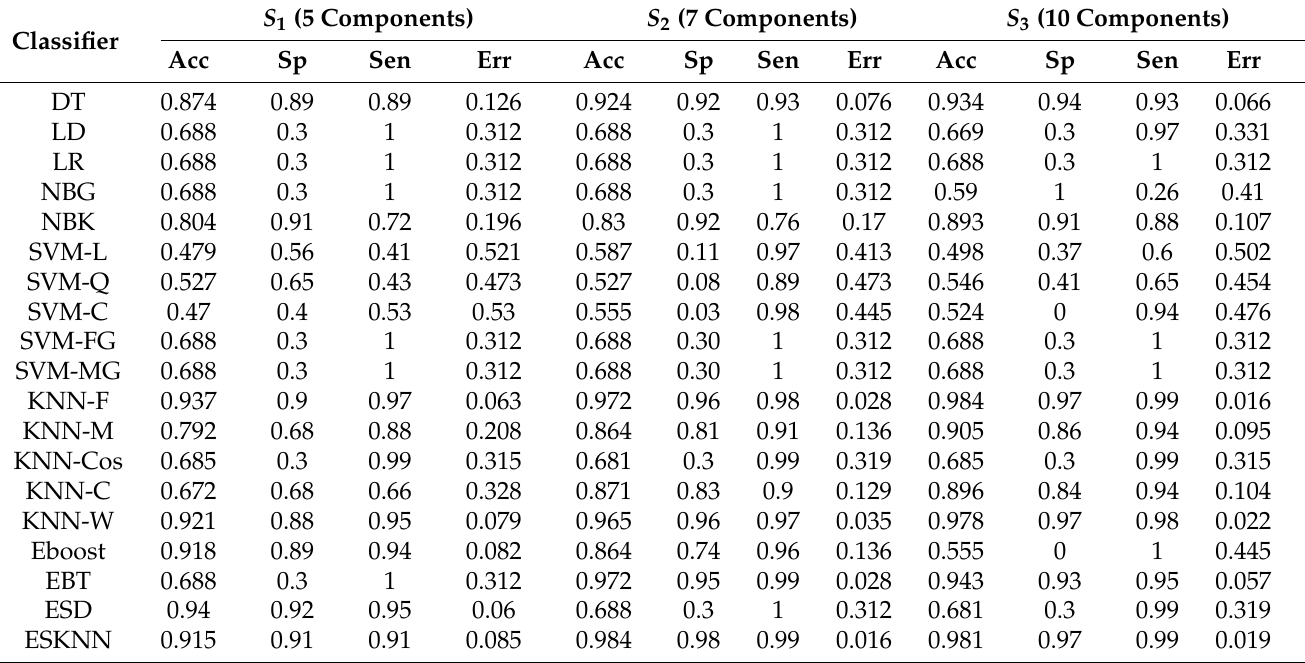
Table 9. Consolidated result analysis of feature sets ( S 1 , S 2 , S 3 ) for method I with various classifiers.